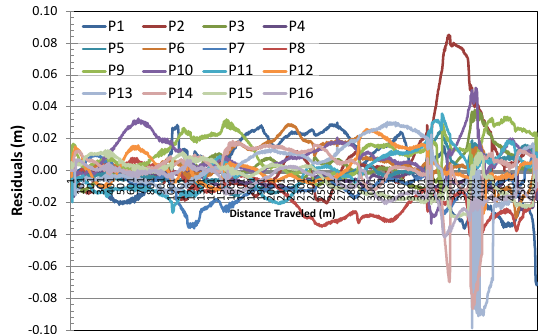
Figure 6. Plot showing residuals of each pass relative to the distance along the CP. A small area of poor data from a few satellites can be seen at chainage 3737 to chainage 4204.